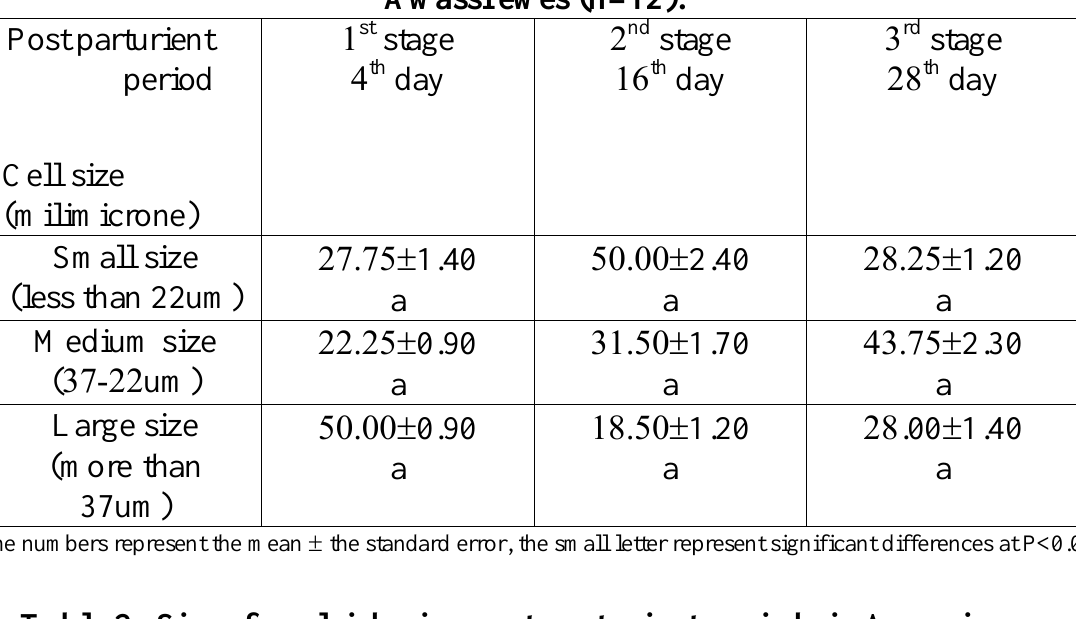
Table 2: Size of nuclei during post parturient periods in Awassi ewes